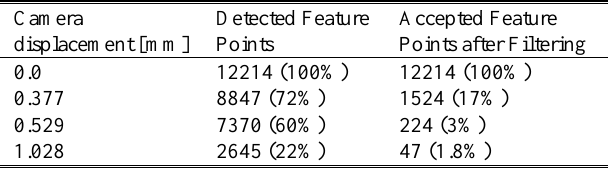
Table 1. Impact of increasing image blur and feature detection. With increasing image blur the number of detected and accepted feature points reduces rapidly.